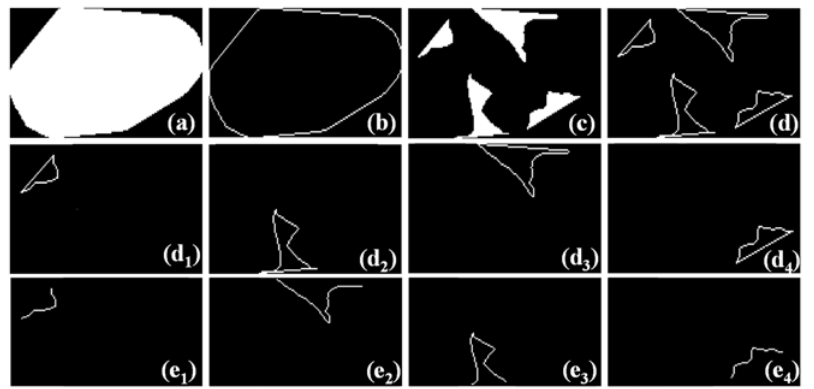
Figure 5. Image processing process: ( a ) Convex hull binary image, ( b ) Convex hull edge binary image, ( c ) Concave defect binary image, ( d ) Binary image of concave defect edge, ( d 1 – d 4 ) The ( d ) separate connected domain image, ( e 1 – e 4 ) Figure 5d 1 –d 4 minus the result of Figure 5b. by2 1 (d 1 ), by2 2 (d 2 ), by2 3 (d 3 ), by2 4 (d 4 ), …, by2 p are subtracted from the edge image The edge binarization images by1 (b) and by2 (d) of convex hull binarization image bw1 (a) and concave defect binarization image bw2 (c) are obtained. by2 (d) is